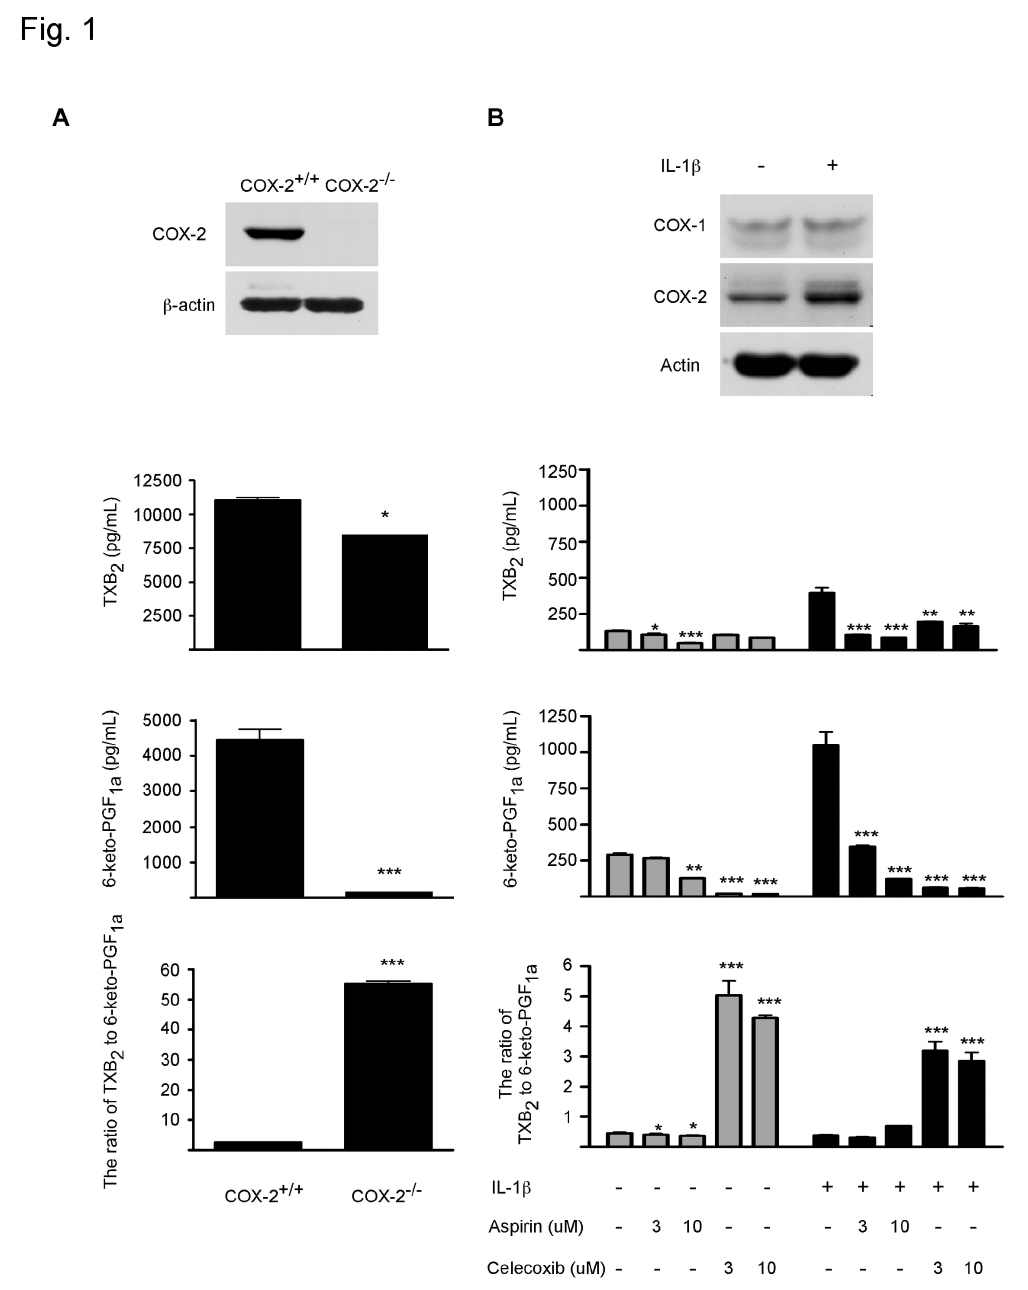
Figure 1. Effect of COX-2 inactivation on TXB and 6-keto-PGF in murine embryo fibroblasts. A. COX-2 deficiency 2 1α enhanced the ratio of thromboxane B to 6-keto prostaglandin F . Western blot analysis of murine embryo fibroblasts (MEFs). Cells 2 1α (6×10 5 ) were seeded in a six-well plate in the presence of 10% FBS. When cell reached 70-80% confluence, fresh culture medium (1 mL/well) was added. After further incubation for 24 h, supernatant fractions were collected for prostaglandin measurement. Data are presented as means ± S.E.M (n = 4) and the asterisk(s) indicate a significant (*, p < 0.05; ***, p < 0.001) difference versus the COX-2 wildtype group. B. COX-2 inhibition enhanced the ratio of thromboxane B to 6-keto prostaglandin F . Human umbilical vein 2 1α endothelial cells (HUVECs) were seeded in a six-well plate in the presence of 10% FBS. At 70-80% confluence, cells were pretreated with 1 mL fresh medium containing DMSO or each individual compound for 2 h, and then IL-1β (17.5 ng/mL) was added together with each individual compound for another 8 h incubation. Supernatant fractions were collected for prostaglandin measurement. Data are presented as means ± S.E.M. (n = 4) and the asterisk(s) indicate a significant (*, p < 0.05; **, p < 0.01; ***, p < 0.001) difference versus Control. doi: 10.1371/journal.pone.0076452.g001 PLOS ONE |